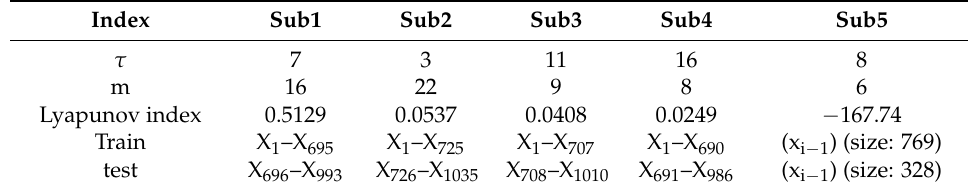
Table A6. The parameters of each subsequence decomposed by EMD of the Shenzhen carbon price.